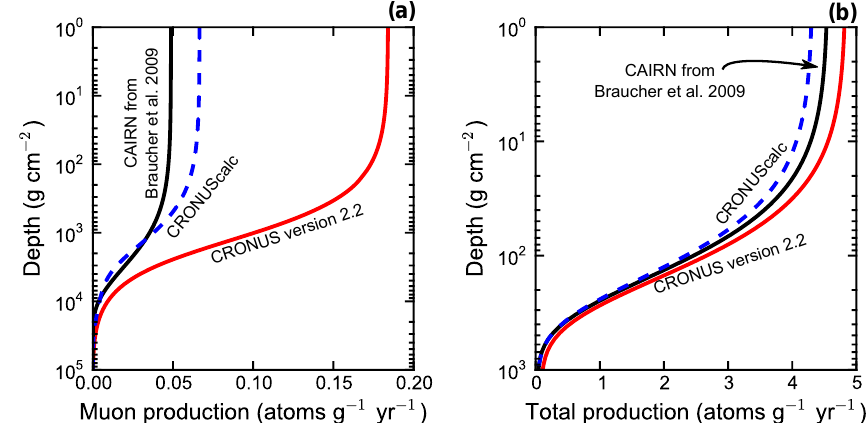
Figure 8. Production rates of 10 Be as a function of depth for muons only (a) and total production (b) . These production rates are calculated using the Lal/Stone scaling at 70 ◦ N and with a pressure of 1007hPa (near sea level). Note the logarithmic depth scale: eroding particles spend a large amount of their exposure history below 100gcm − 2 and so increased muon production at these depths, despite being a small fraction of the total production, plays a significant role in determining the total nuclide concentration (see Fig. 9).